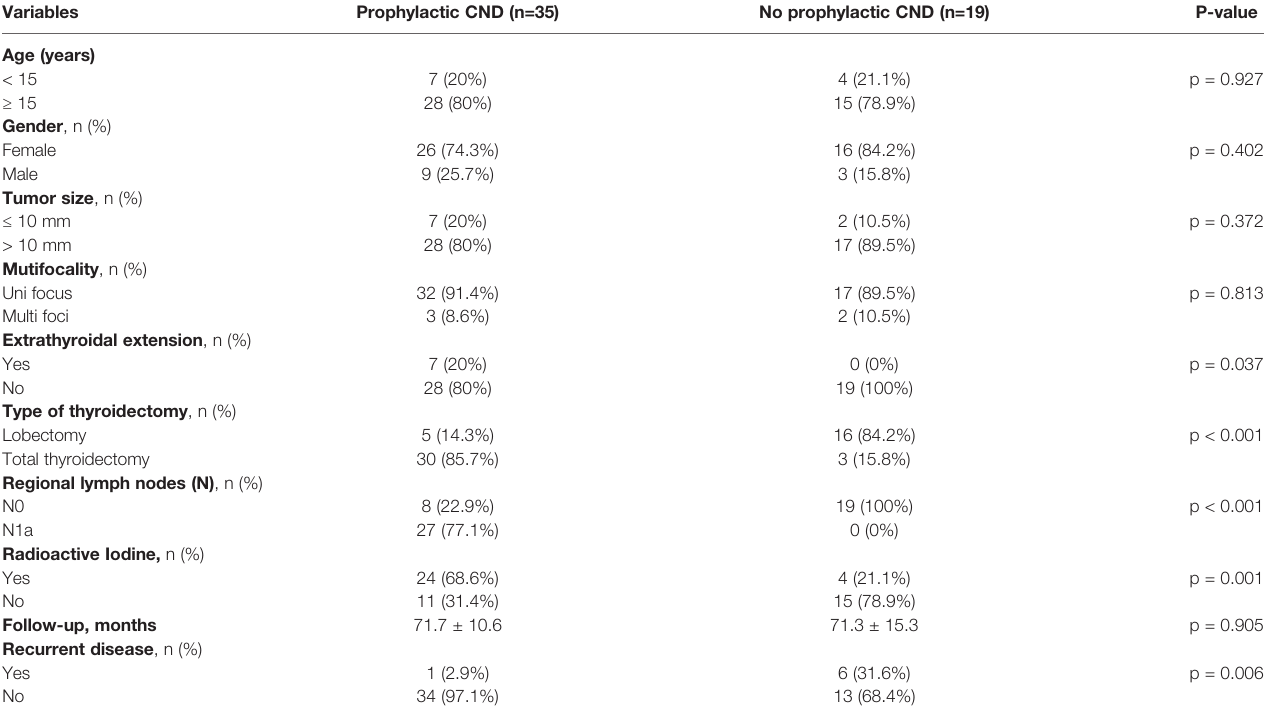
TABLE 2 | Clinicopathological features according to prophylactic central neck dissection. Variables